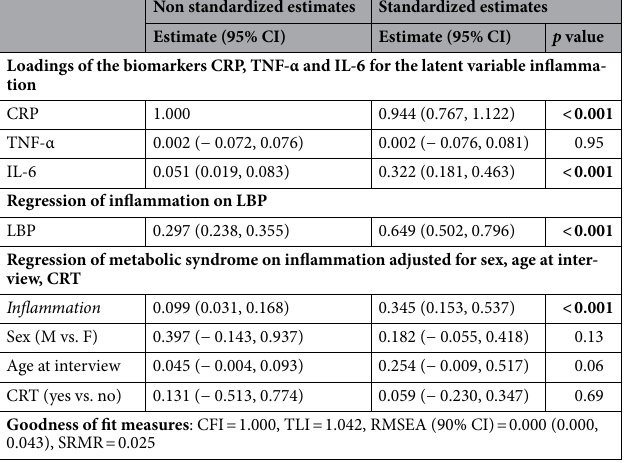
Table 8. SEM estimates of the associations between LBP, inflammation and metabolic syndrome. CRT: cranial radiotherapy; CFI: Comparative Fit Index; LB: LPS binding protein; RMSEA: Root Mean Square Error of Approximation; SRMR: Standardized Root Mean Square Residual; TLI: Tucker-Lewis Index. p values of non- standardized estimates are not shown as they almost identical to p values of standardized